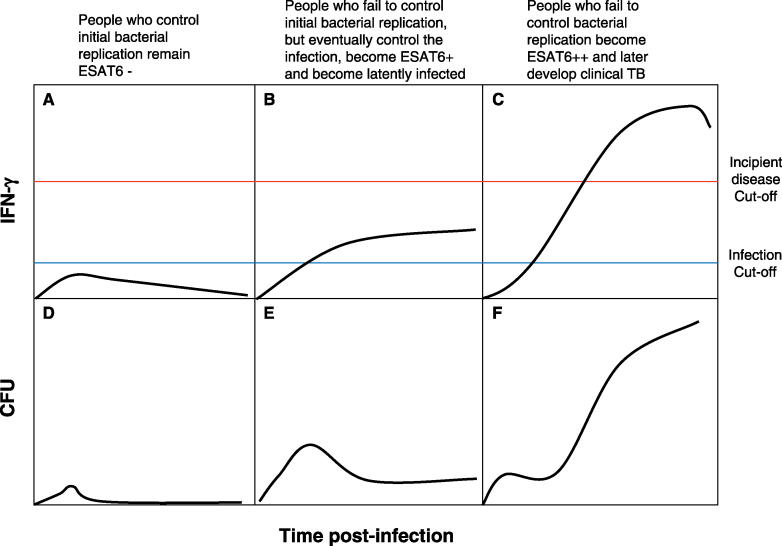
A Schematic of the Postulated Correlation between Bacterial Load, T Cell Response, and Clinical OutcomeInitial infection might be controlled at its onset with minimal bacterial replication (measured as colony-forming units [CFU]) and induction of ESAT-6 responses (A and D). In such cases, the T cell response may be below the diagnostic cut-off. However, in most cases, initial bacterial replication reaches a point at which it induces an ESAT-6-specific IFNγ response to increase above the established cut-off value (infection threshold), enabling the diagnosis of an individual as latently infected (B and E). In most cases, individuals control the infection, resulting in latent infection, but some develop active TB disease associated with progressive bacterial replication. This is accompanied by increasing and strong ESAT-6 responses and, as hypothesized here, an incipient (higher) disease cut-off value may predict subsequent development of progressive disease (C and F).Reproduced with permission from [13].